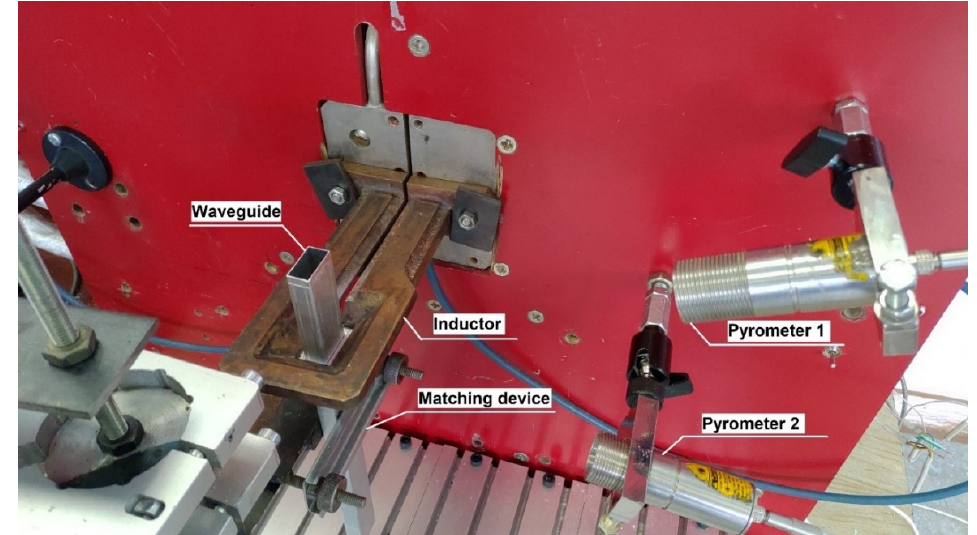
Figure 2. Induction brazing installation.